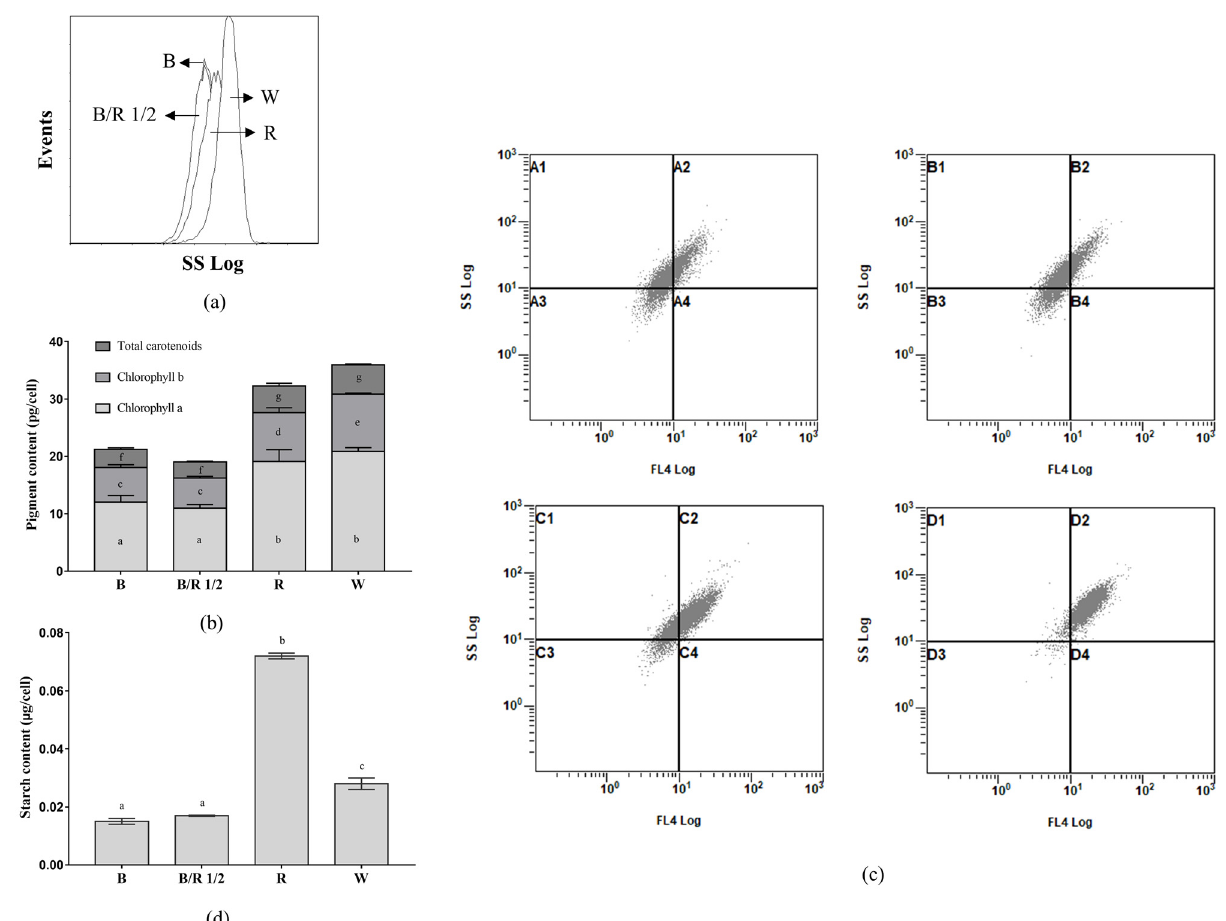
Figure 3. Effects of light spectra on the intracellular granularity and photosynthetic pigment con- tents of H. pluvialis green cells. ( a ) Distribution of SSC signals of cells at the end of cultivation; ( b ) photosynthetic pigment contents in cells at the end of cultivation. For each pigment class, the same lowercase letter means insignificant difference, while different lowercase letters mean significant difference; ( c ) 2D scatter plot of FL4 signals (chlorophyll autofluorescence) vs. SSC signals (intra- cellular granularity), upper left—blue light; upper right—blue/red light 1/2; lower left—red light; lower right—white light. ( d ) Starch contents in cells at the end of cultivation. The same lowercase letter means insignificant difference, while different lowercase letters mean significant